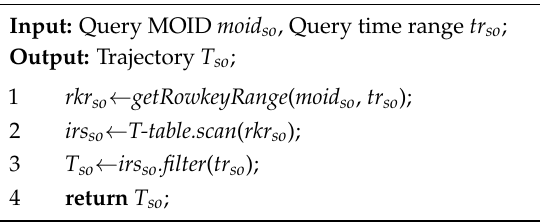
Algorithm 1. Single-Object